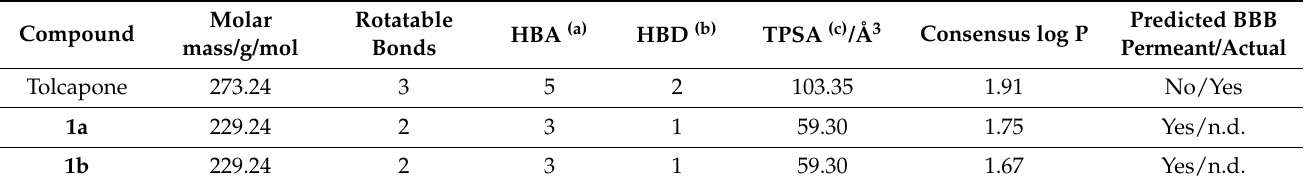
Table 2. Moledcular descriptors relevant to BBB Score of tolcapone, 1a and 1b in their neutral form.